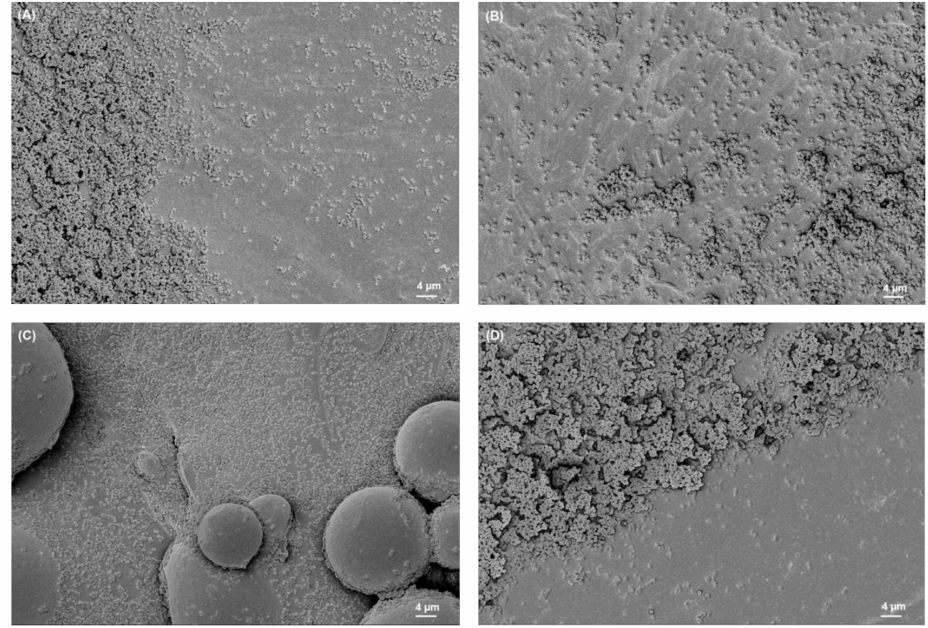
Figure 3. S. aureus biofilm on ( A ) Ti grade 23, ( B ) Ti grade 2, ( C ) Ti grade 5, ( D ) Ti grade 5 polished. All images were recorded at high voltage of 5 kV, magnification = 1.18 KX with scale bars = 4 µ m.